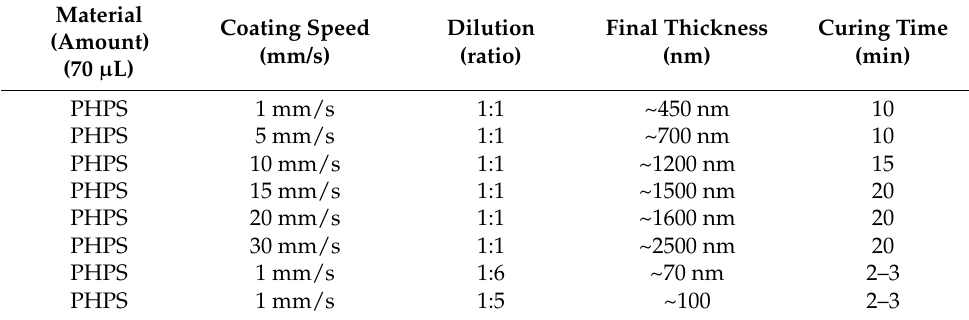
Table 1. Parameters for coating PHPS layers on PET substrate.